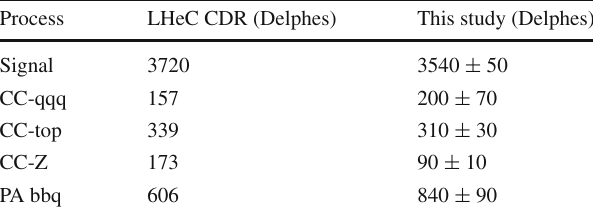
Table 2 Expected event yields for signal and background processes in the signal region (100 < m bb < 130), for cut-based analysis of the official LHeC CDR [2] (taken from Fig. 3) alongside this